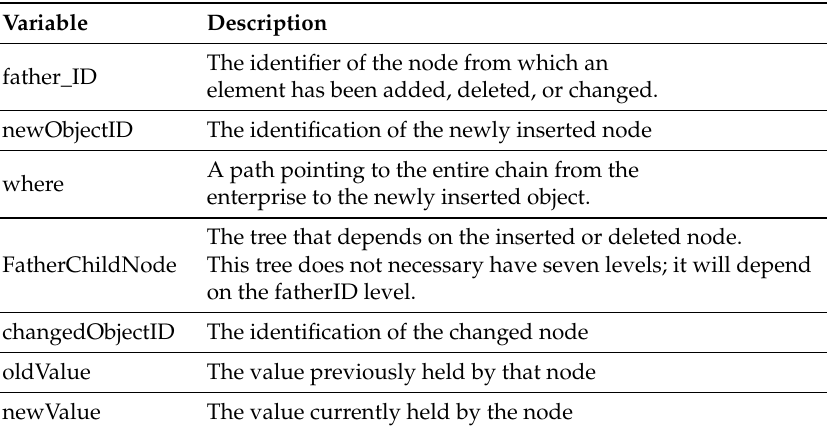
Table 4. A description of the information saved in each Diff